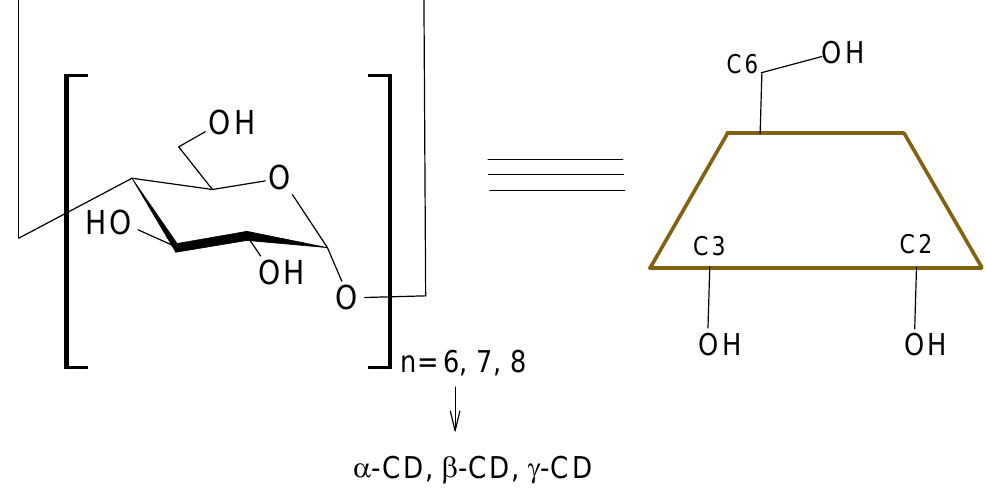
Figure 1. Structure of cyclodextrins.